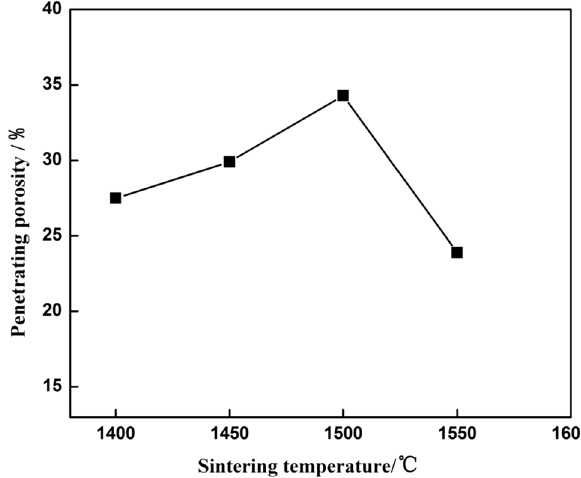
Fig. 8 Effect of sintering temperature on penetrating porosity of sup- ports sintered at different temperatures (1400–1550